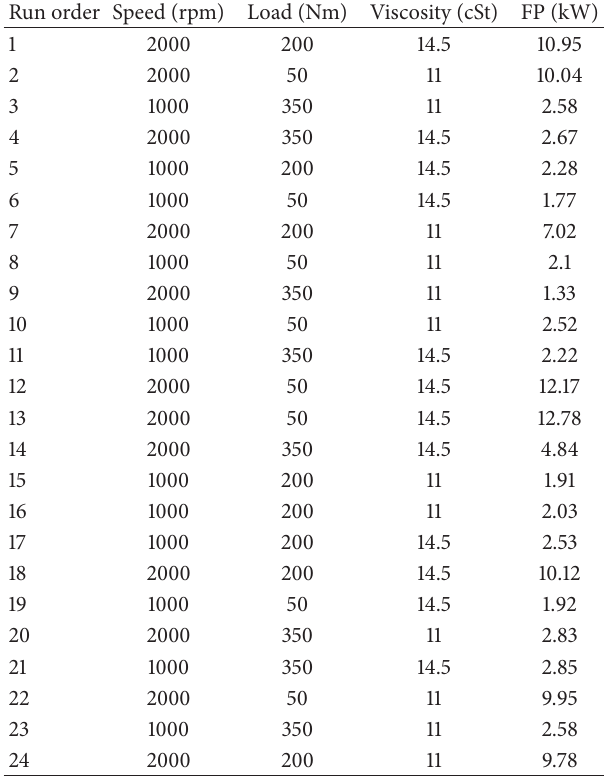
Table 3: Factors with its levels of experiment. Table 4: Full factorial design of experiments comprising variables speed, load, oil viscosity, and response variable friction power (FP) in